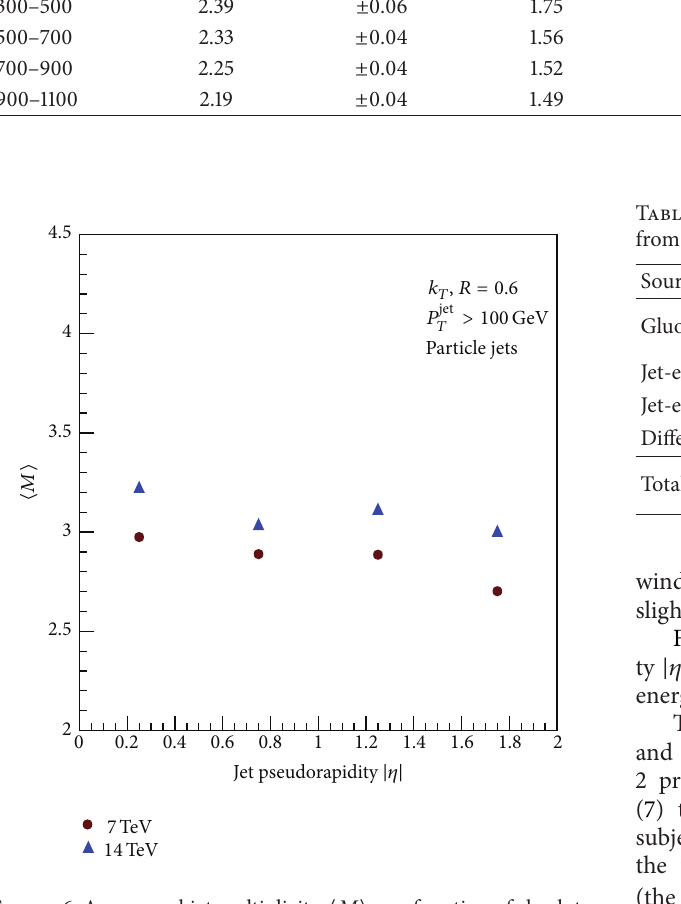
Figure 6: Average subjet multiplicity ⟨𝑀⟩ as a function of absolute jet pseudorapidity |𝜂| for the whole range in ̂𝑝 𝑇 at √𝑠 = 7 TeV and √𝑠 = 14 TeV for 𝑘 𝑇 algorithm.